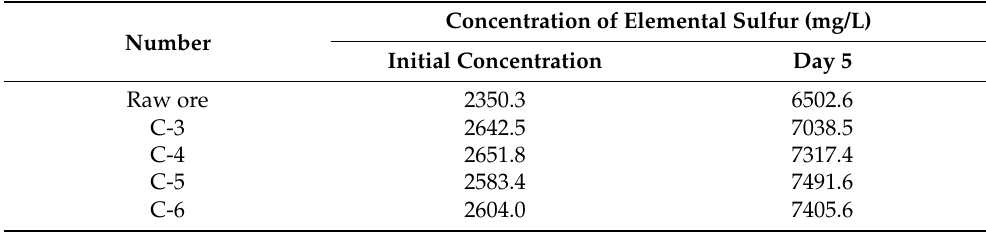
Table 11. Results of the experiment on the effect of ultrasonic action time on desulfurization rate.